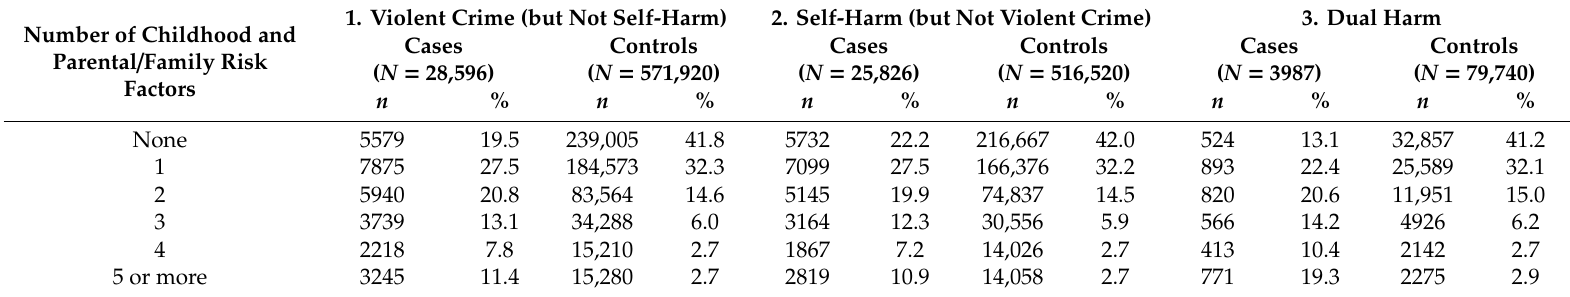
Table 2. Exposure prevalence by number of childhood adversity risk factors among cases vs. controls for the 3 behavioral outcome categories. 1. Violent Crime (but Not Self-Harm) 2. Self-Harm (but Not Violent Crime) 3. Dual Harm Number of Childhood and Cases Controls Cases Parental / Family Risk Factors